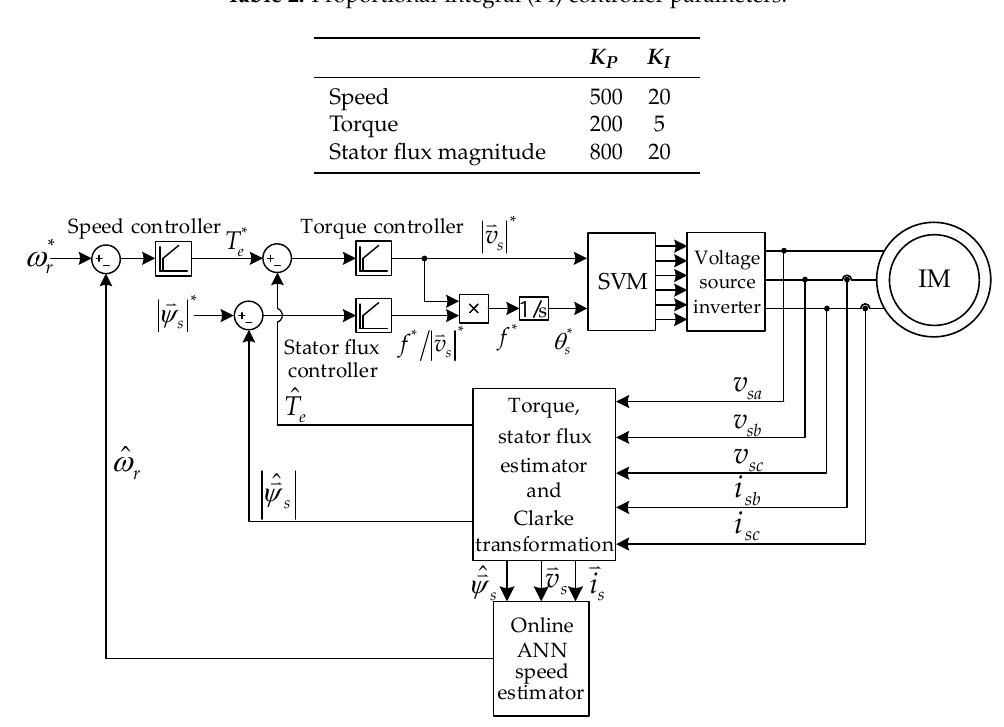
Figure 3. The block diagram of the proposed sensorless speed control system.